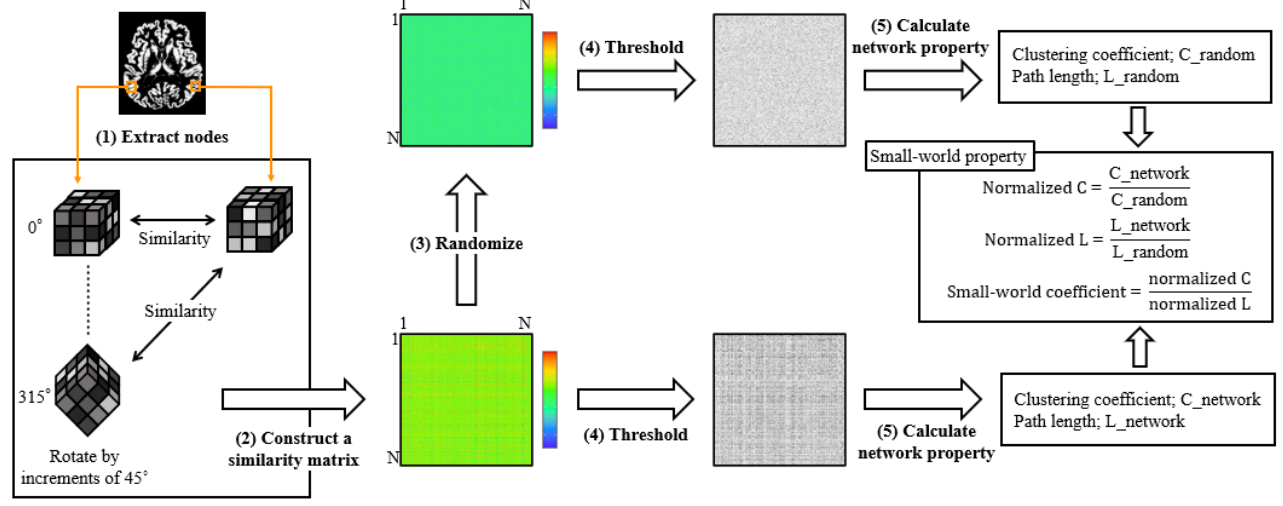
Figure 2. The pipeline of similarity-based gray matter network analysis. After preprocessing, the extracted gray matter image was resliced into small brain regions of 3 × 3 × 3 voxel cubes (1). After the identification of maximum similarity value by rotating each cube with an angle θ , the similarity between all the nodes was calculated with the correlation coefficient, and a similarity matrix was constructed (2). Five random matrices were also constructed for each similarity matrix